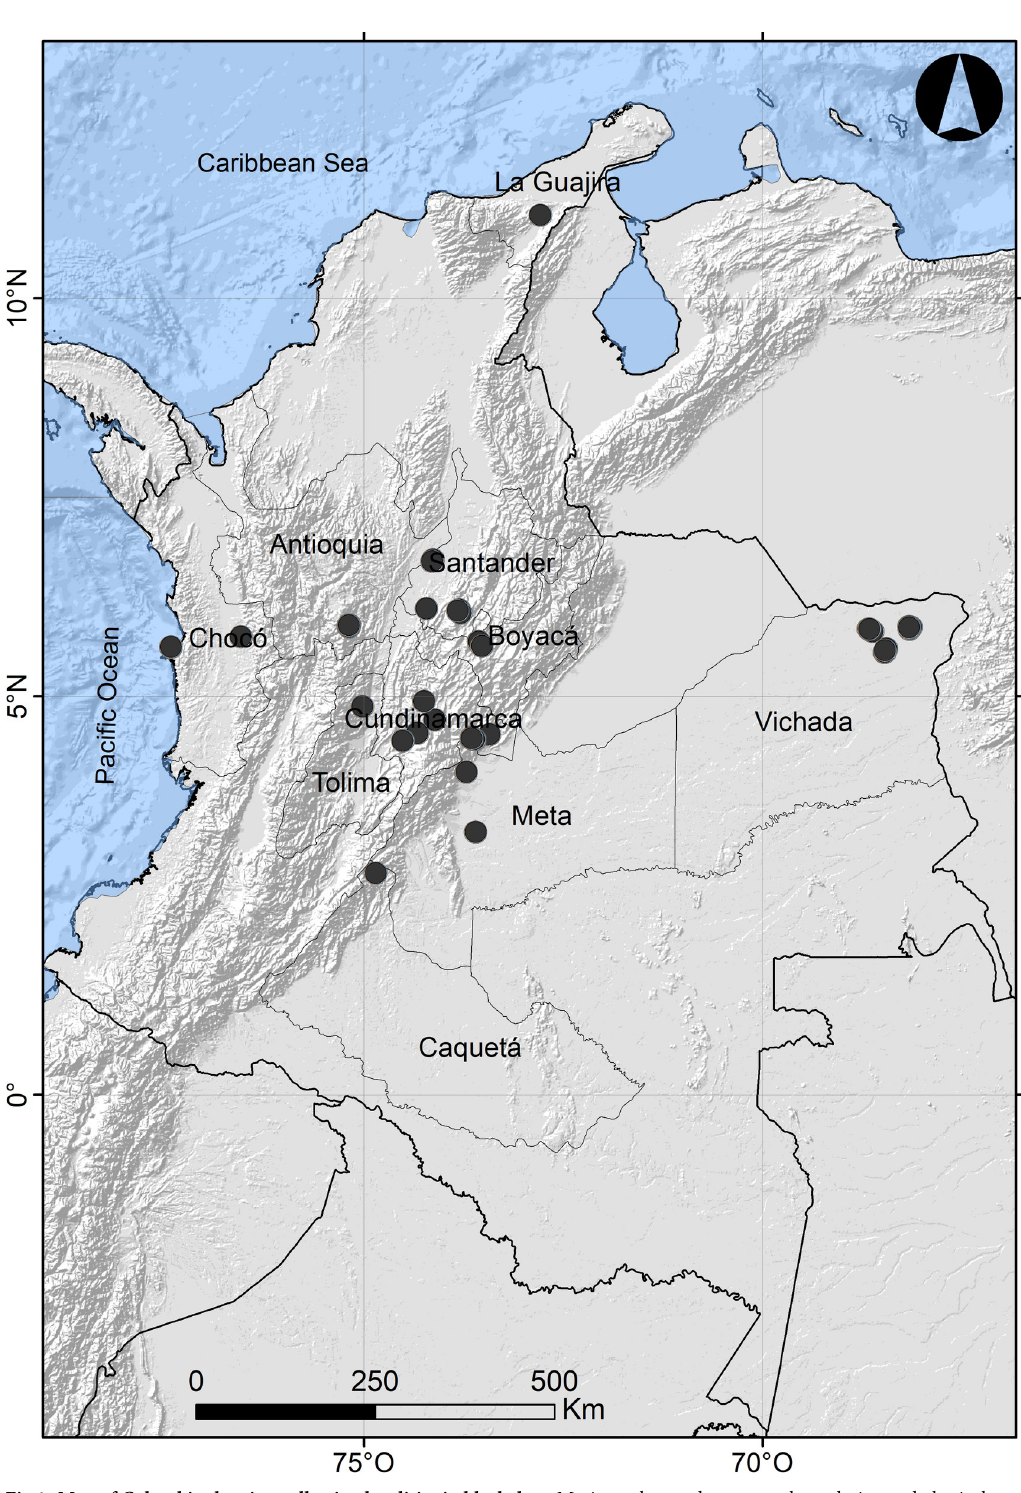
Fig 1. Map of Colombia showing collecting localities in black dots. Marine polygon, department boundaries, and physical labels were obtained from Natural Earth (http://www.naturalearthdata.com/). Hillshade map based on SRTM30_PLUS v8 [26].